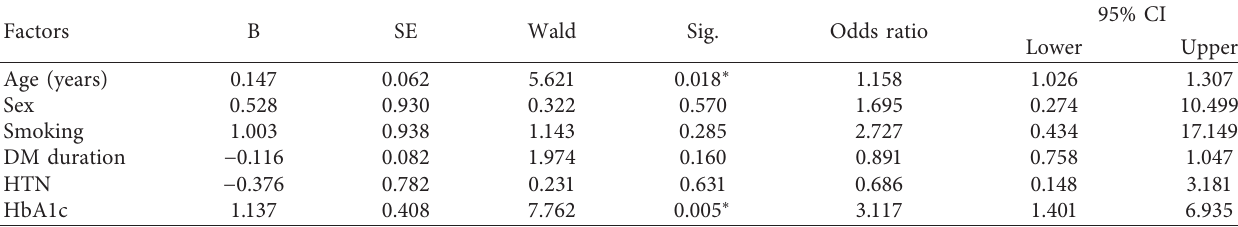
Figure 2: Positive and significant correlation between the RBDSQ score and HbA1c. Table 3: Logistic regression analysis of factors affected the RBDSQ in diabetic patients.